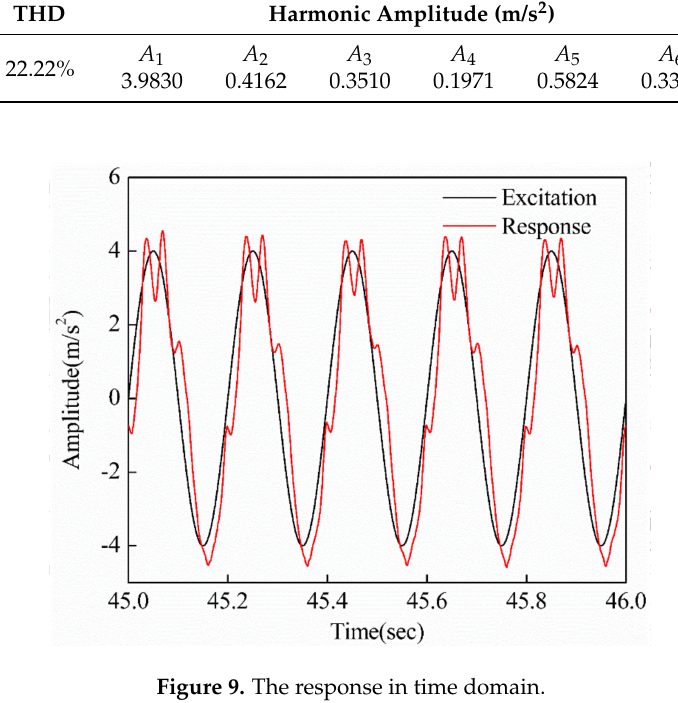
Figure 9. The response in time domain.